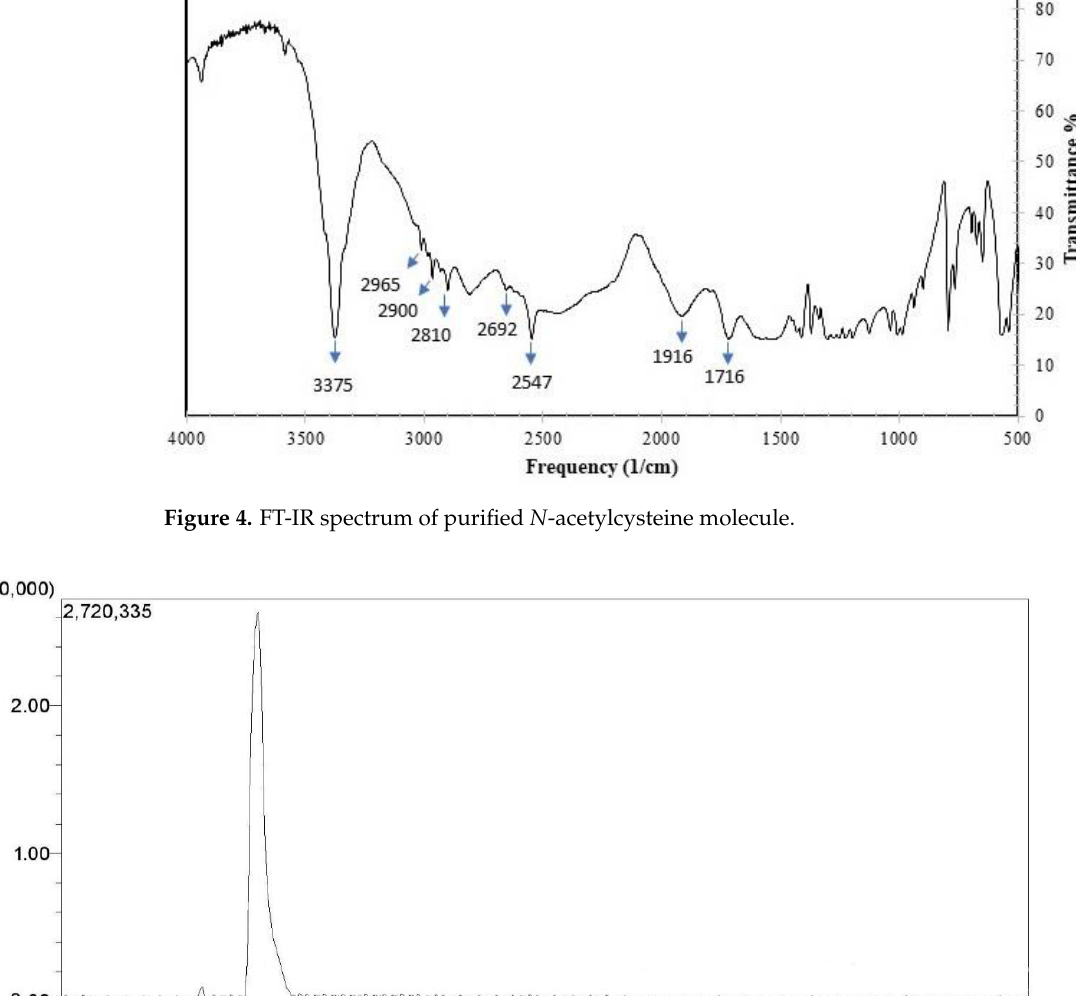
Figure 4. FT-IR spectrum of purified N -acetylcysteine molecule.